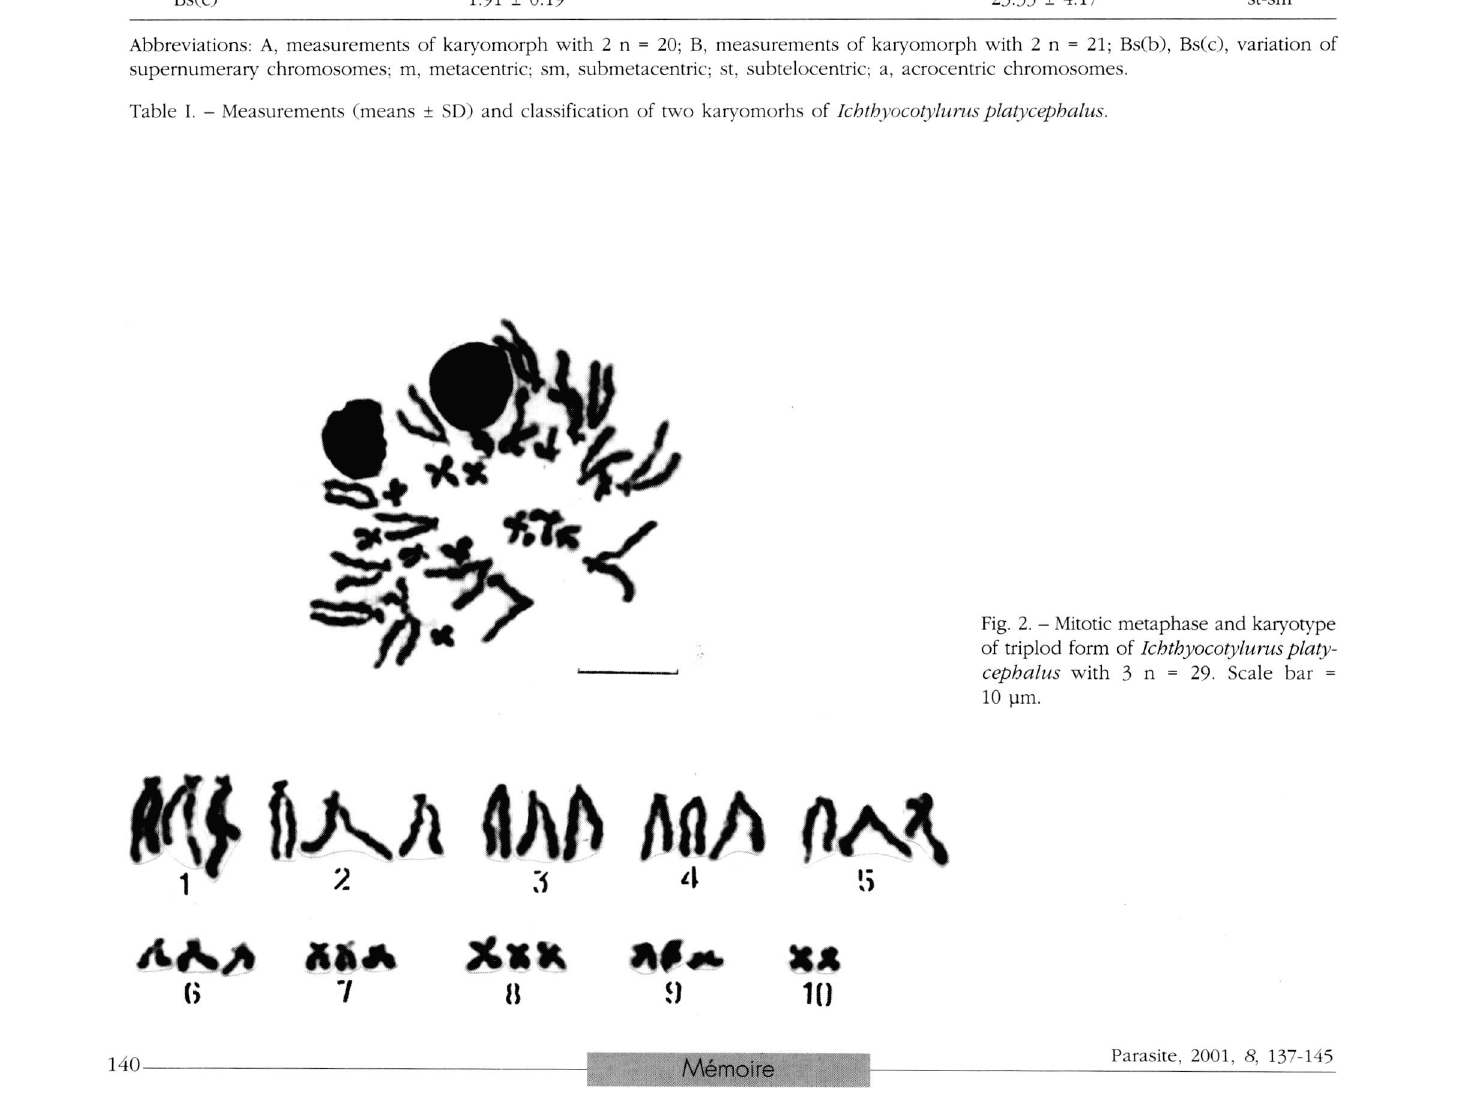
Fig. 2. - Mitotic metaphase and karyotype of triplod form of Ichthyocotylurus platy­ cephalus with 3 n = 29. Scale bar = 10